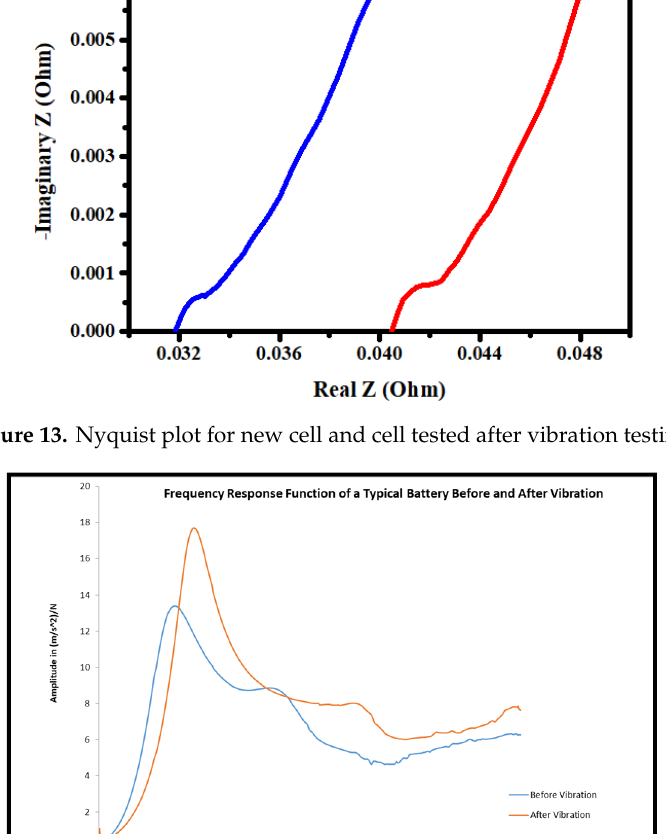
Table 2. Frequency response function (FRF) analysis of new cell.